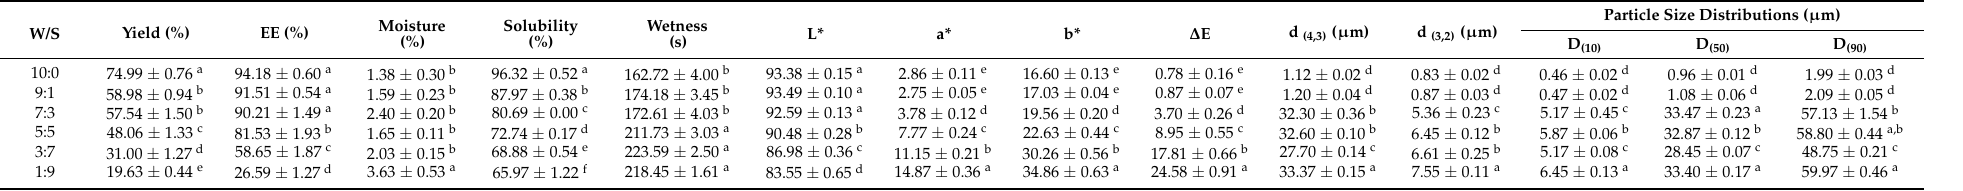
a W/S represents the ratio of whey protein to citrate mung bean starch. b EE represents the encapsulation efficiency. L*: lightness; a*: redness; b*: yellowness; ∆ E: color difference. c All values are presented as mean ± standard deviation, and all of the measurements were performed in triplicate. Different letters within each column indicate significant differences, p ≤